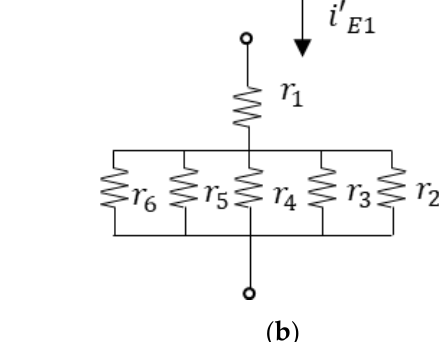
Figure 10. Load side magnetic circuit when only E 1 is supplied: ( a ) hexagon configuration; ( b ) star configuration.